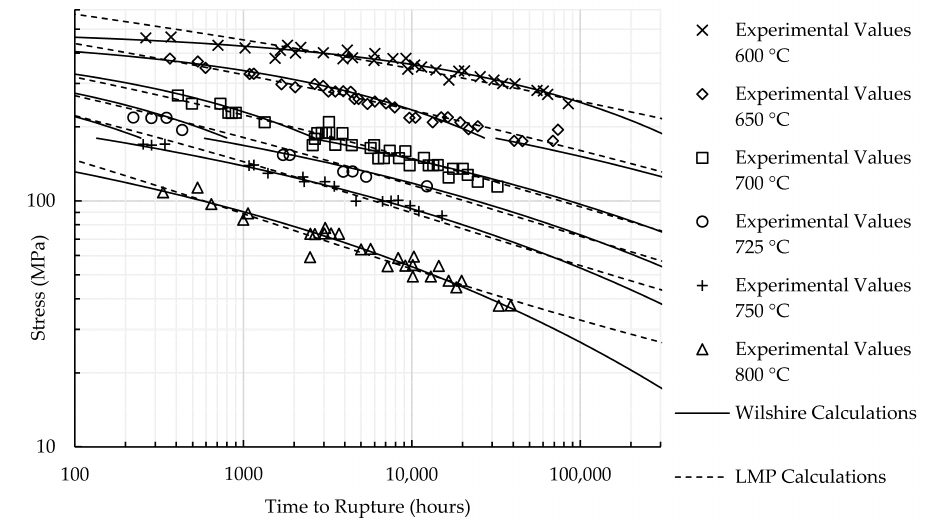
Figure 7. Calculated rupture times for HR6W.